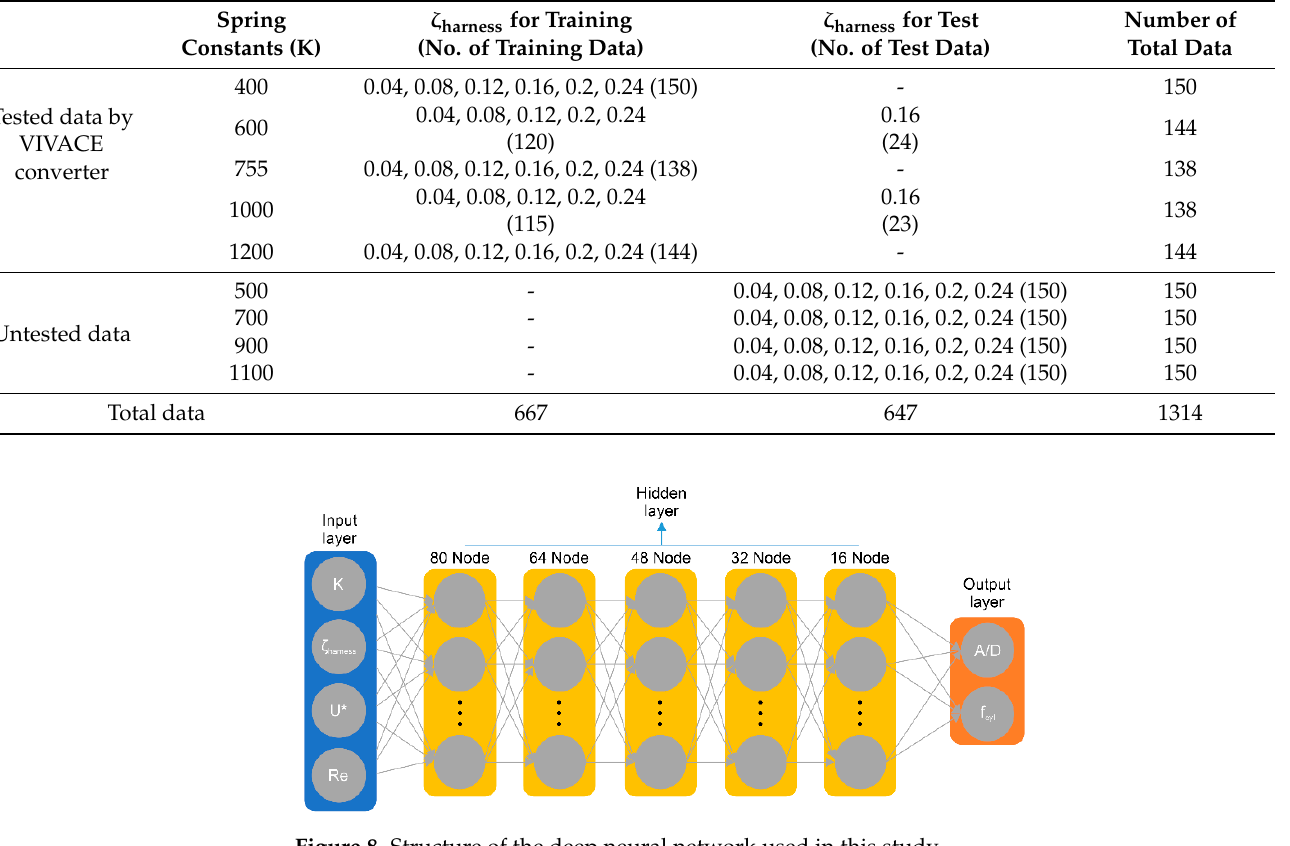
Table 4. Data classification for learning in deep learning models.